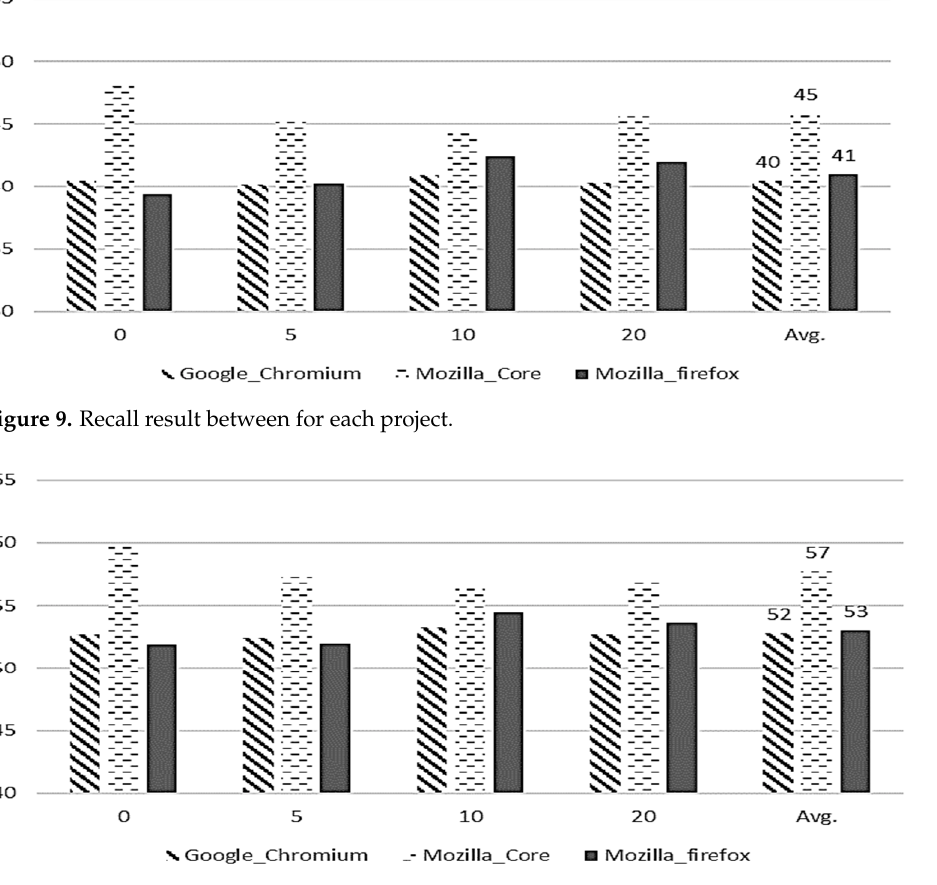
Figure 10. F-measure result between for each project.